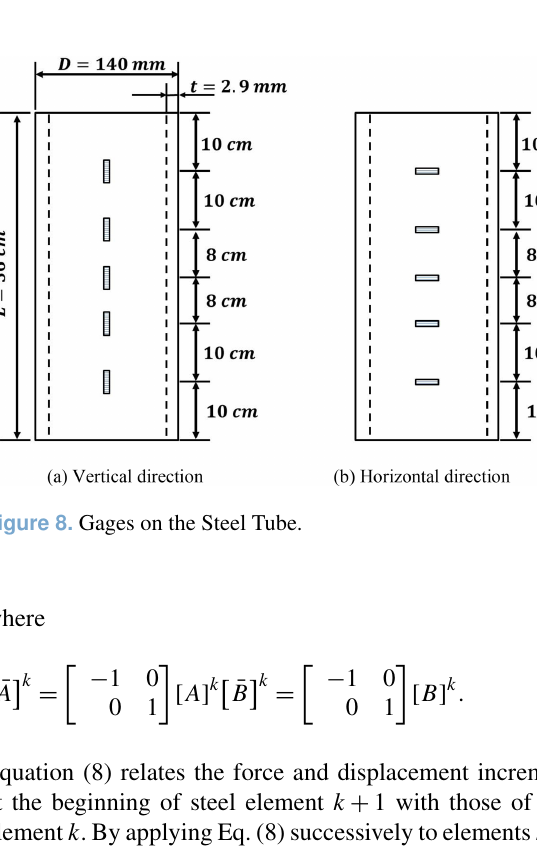
Figure 7. Flow chart of bond-slip algorithm.